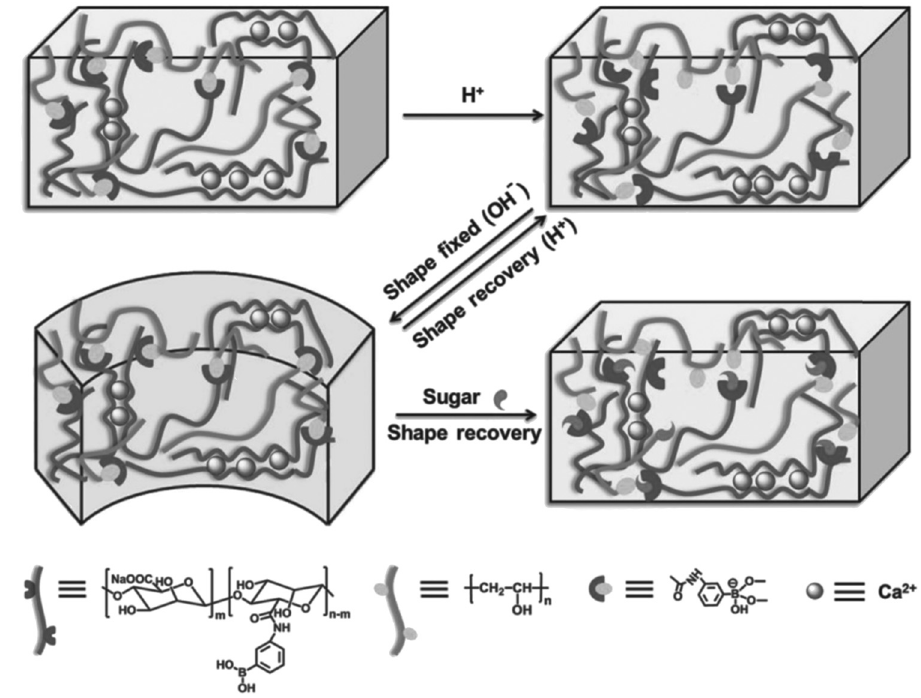
Figure 7: The shape memory mechanism of Alg - PBA - PVA hydrogels. Copyright 2015, John Wiley & Sons – Journals ( 95 )